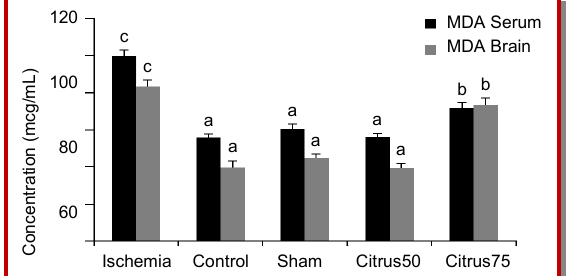
Figure 5 : Comparison of the serum and brain MDA level, Similar letters represent no significant difference and dis- similar letters represent significant difference (p